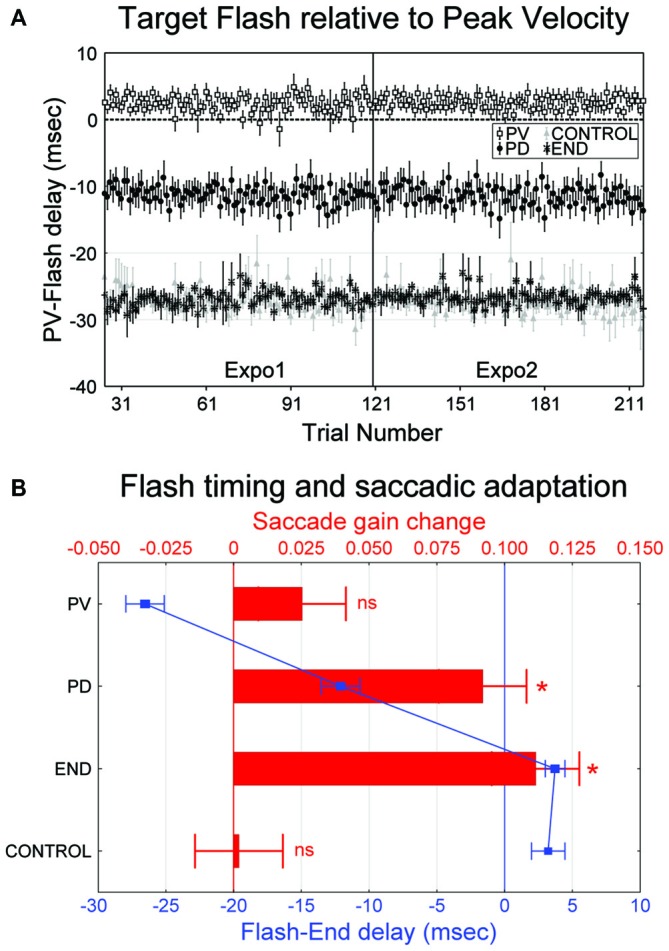
(A,B) Occurrence of the 2 ms flash and its relation with saccadic gain change (experiment I). (A) The mean onset time of the target flash relative to the time of peak velocity (“Flash-PV” delay) across the 15 subjects is plotted as a function of trial number. Negative (positive) values indicate flash following (preceding) the saccade peak velocity. Error bars are SEMs. (B) Mean change of saccadic gain in post relative to pre (red bars, upper x-axis) and mean onset time of the flash relative to saccade end (“Flash-END” delay, blue curves and symbols, lower x-axis) are represented as a function of the four experimental conditions (“PV”, “PD”, “END” and “CONTROL”). Positive gain changes indicate gain decrease. Significant differences of gain changes relative to zero (Student t-test) are indicated by: *p < 0.05. Negative values of “Flash-END” delay indicate intra-saccadic flash. Errors bars are SEMs.